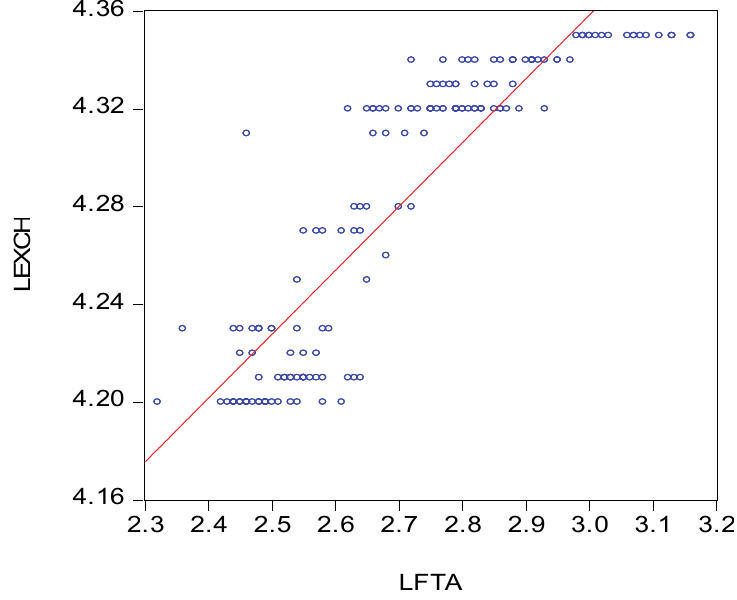
Fig. 4. Exchange rate and foreign tourist arrivals to